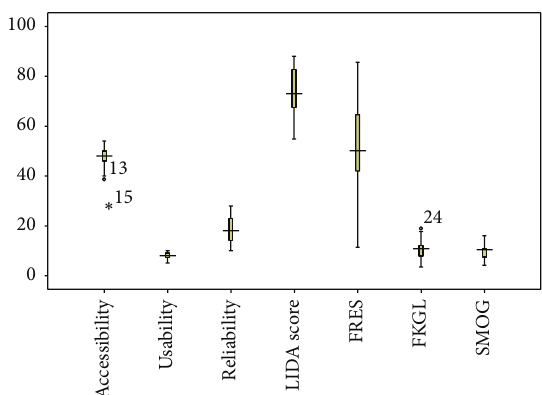
Figure 1: Box-and-whisker plot showing mean quality and readabil- ity scores of health information